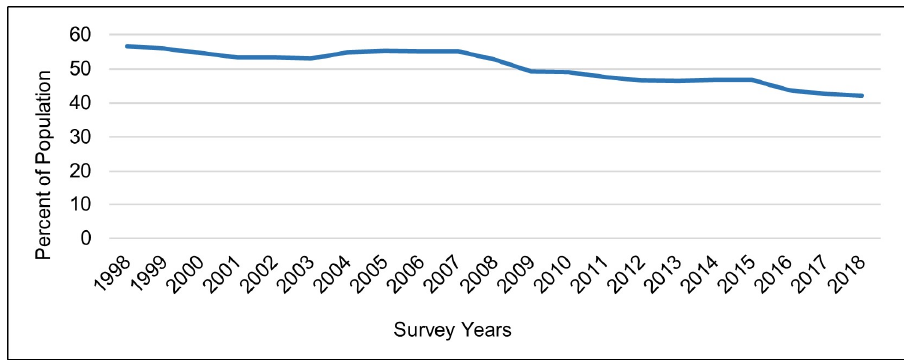
Figure 1. Trends in leisure-time physical inactivity among U.S. adults. Source of data: [2].